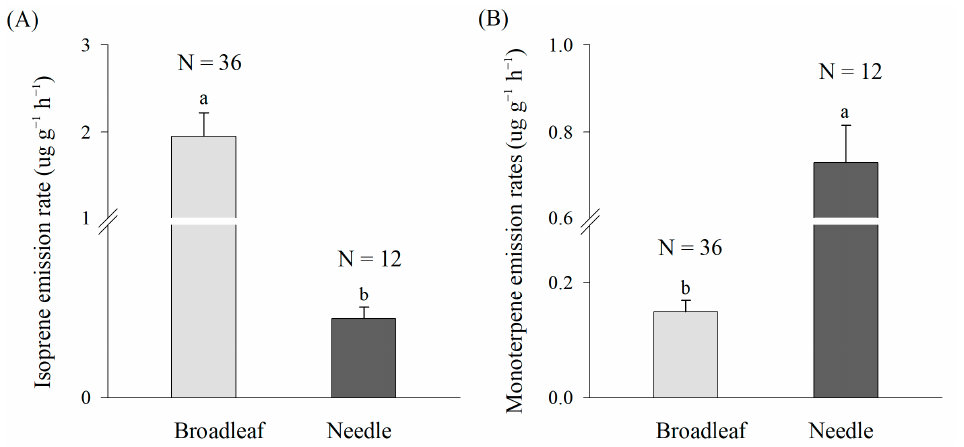
Figure 3. Emission rates of isoprene ( A ) and monoterpenes ( B ) of broadleaf and needle. The data are the mean ± SE. The replicates were 36 for broadleaf and 12 for needle. The different lowercase letters denote significant differences of BVOC emission rates between broadleaf and needle at p < 0.05 level.